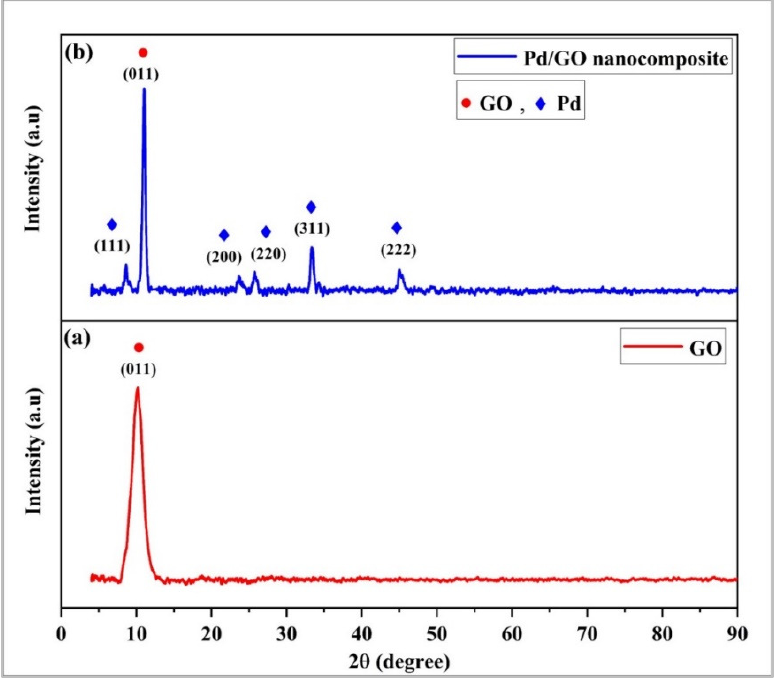
Figure 10. XRD pattern for both samples ( a ) GO thin film and ( b ) Pd/GO nanocomposite thin film.